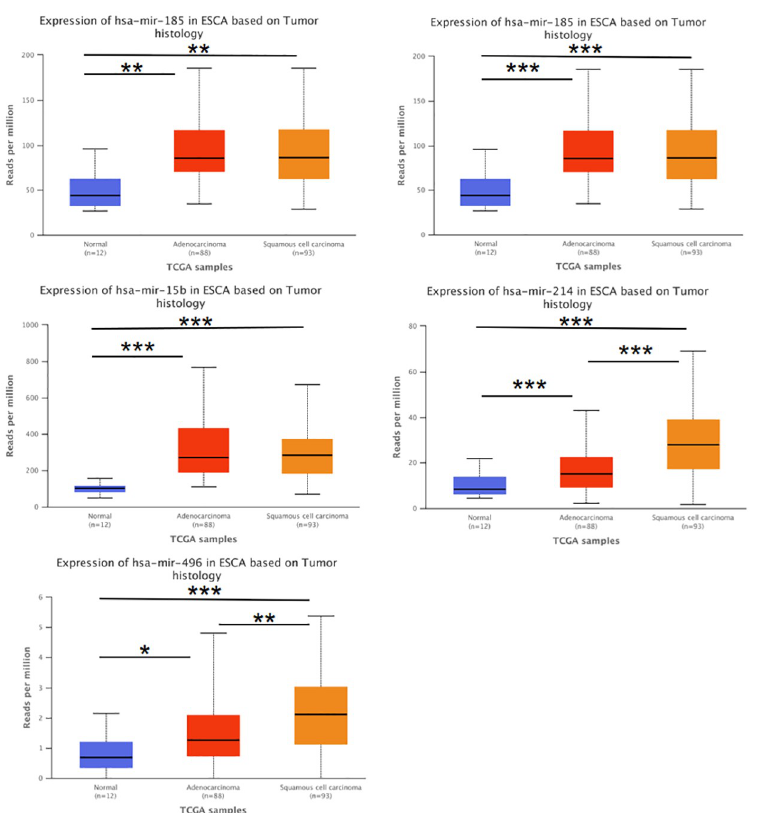
Fig 8. Expression of significant DEMs in the TCGA dataset between normal tissue, EAC and ESCC. Expression of significant DEMs between EAC, ESCC and normal tissue in the TCGA dataset. Blue column represents the expression of normal tissue, red column represents the expression of EAC and yellow column represents the expression of ESCC. The horizontal axis represents different specimens, and the vertical axis represents the number of reads from a gene per kilobase length per million reads. � respresents the P value < 0.05, �� respresents the P value < 0.01, ��� respresents the P value < 0.001.